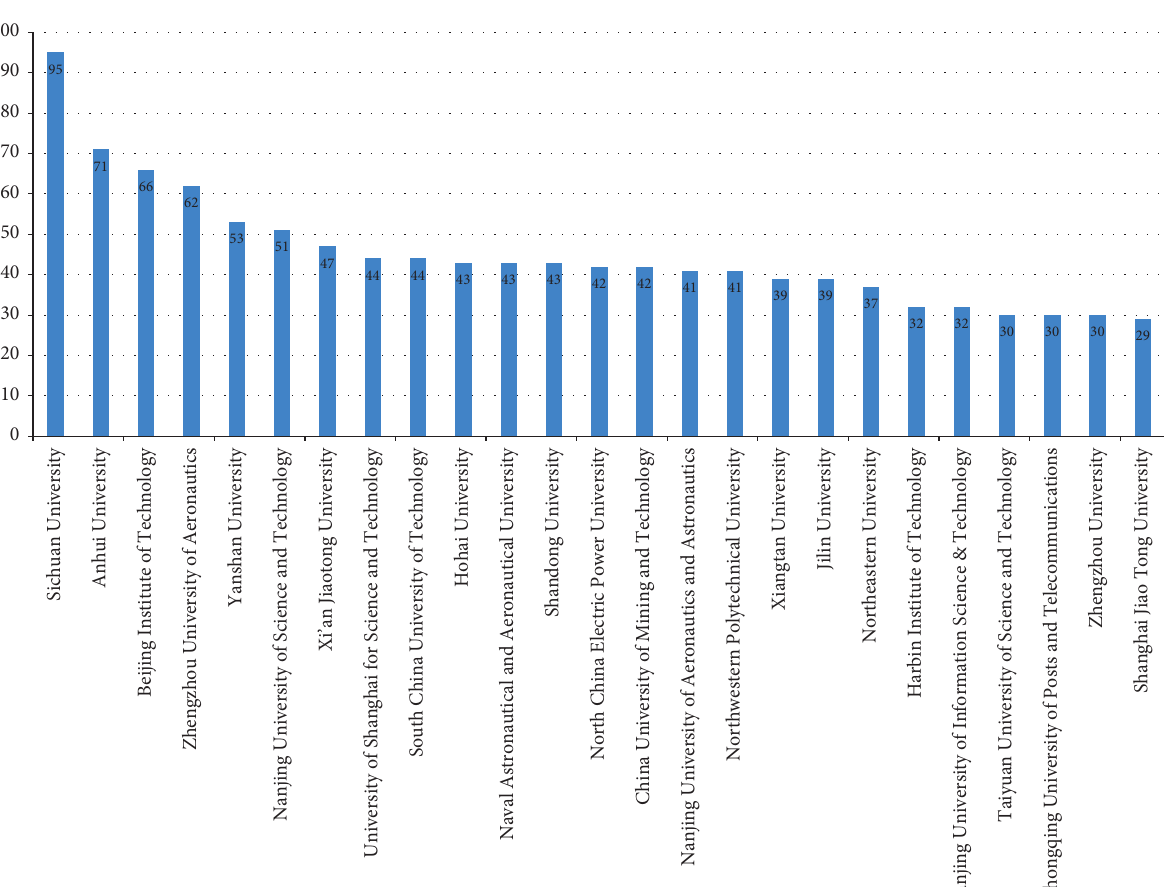
Figure 2: Distribution of main research